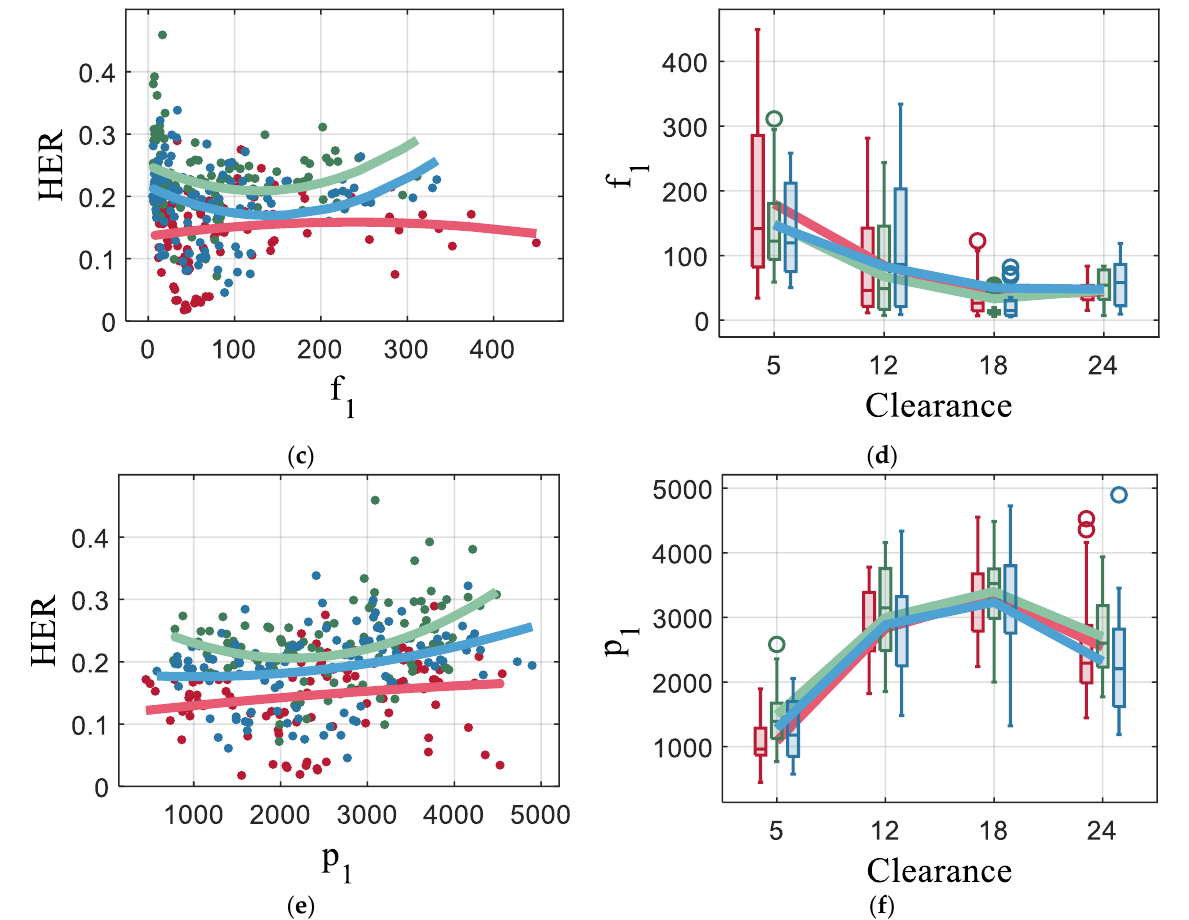
Figure 17. Effects of statical features of image: burnish-related features to ( a ) HER and ( b ) burr; fracture-related feature to ( c ) HER and ( d ) clearance; and peak-related feature to ( e ) HER and ( f ) clearance.